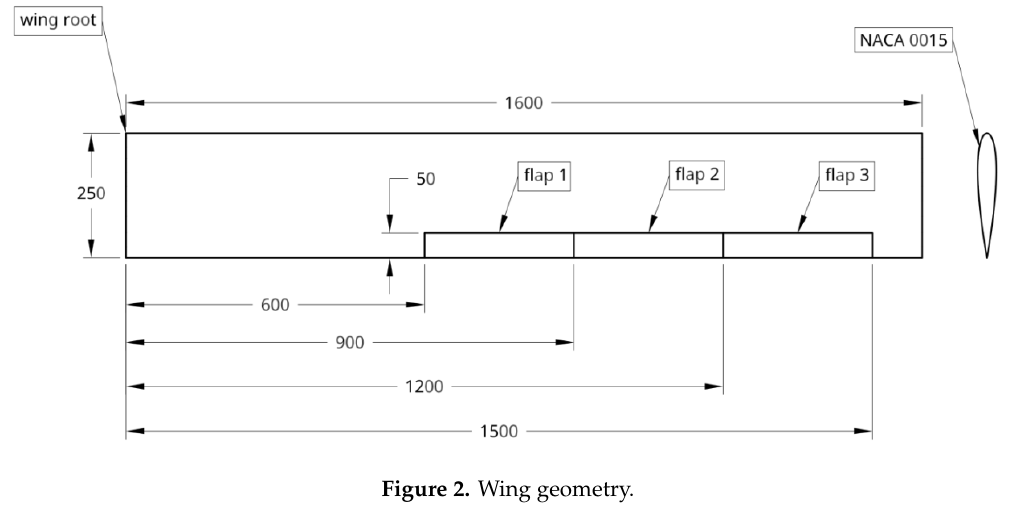
Figure 2. Wing geometry.